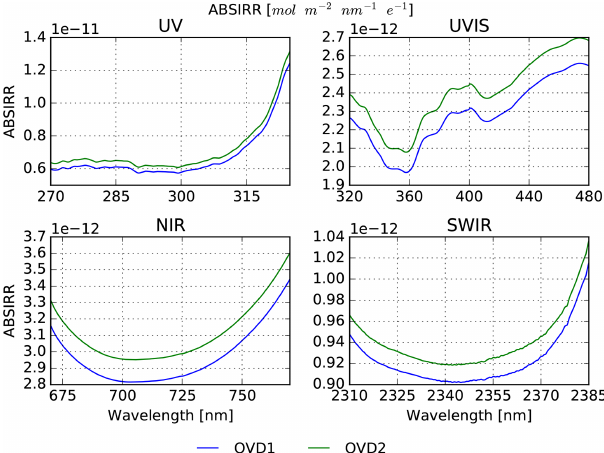
Figure 15. Absolute irradiance CKD at the optical axis row (QVD1 in blue, QVD2 in green) for all spectrometers over their perfor- mance range. For each QVD the CKD are the mean of the absolute irradiance calculated from FEL1 and FEL2 at distance d 1 .